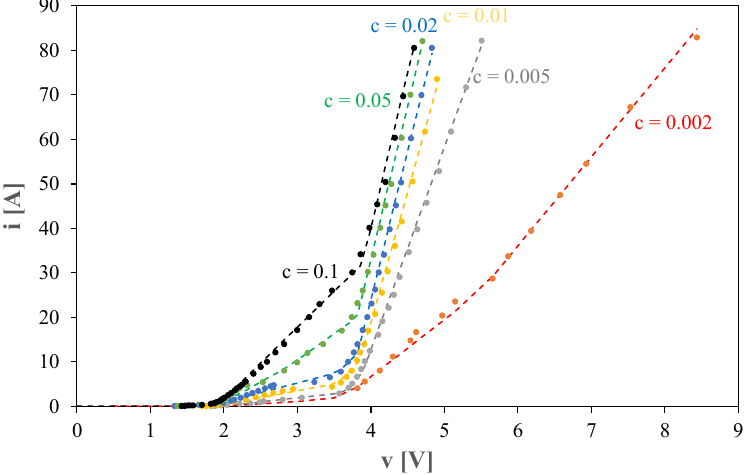
Figure 3. Calculated and measured DC current–voltage characteristics of the electrolyzer.